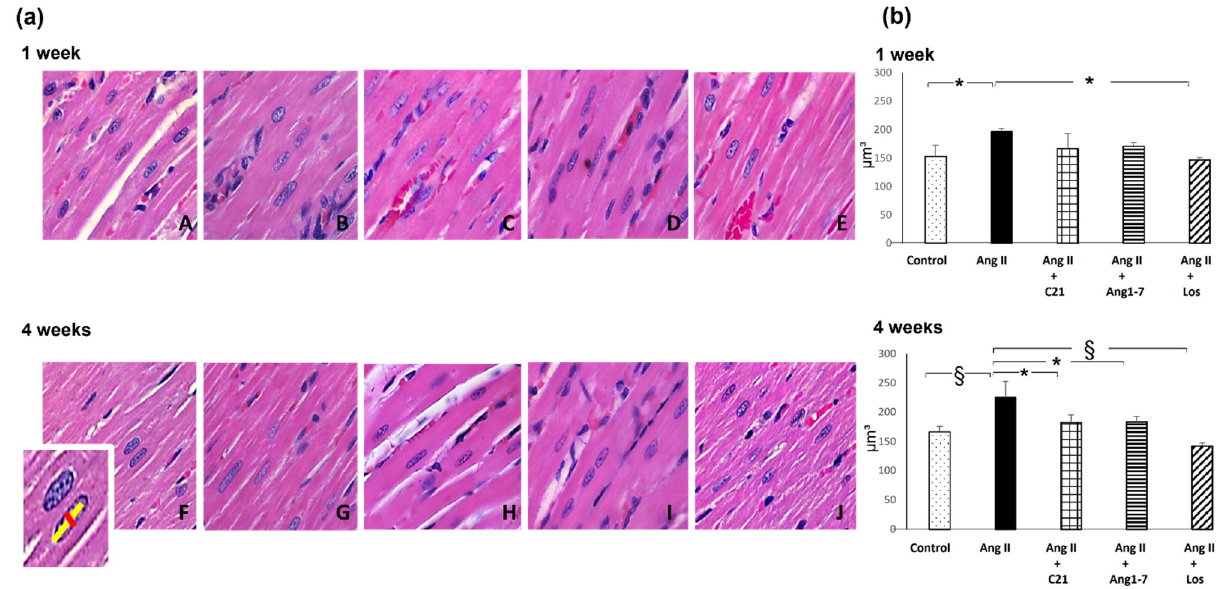
Figure 3. Myocardial hypertrophy. Effect of C21 and Ang 1-7 administration on myocardial hypertrophy in Ang II treated rats for 1 and 4 weeks. ( a ). Representative images of histological left ventricular sections in control (A,F), Ang II (B,G), Ang II + C21 (C,H), Ang II + Ang 1-7 (D,I) and Ang II + Losartan (E,J) treated rats (H&E, 40X magnification), respectively at 1 and 4 weeks of treatment, that show hypertrophy with related enlarged volume of cardiomyocyte nuclei in Ang II treated rats (B,G) as compared to control rats (A,F) at 1 and 4 weeks of treatment. C21 (H), Ang 1-7 (I) and losartan (J) administration for 4 weeks in Ang II treated rats prevented the development of myocardial hypertrophy. ( b ). Quantification of myocardial hypertrophy in the different groups of rats. Data are means ± SEM. *: p < 0.05. §: p < 0.01.